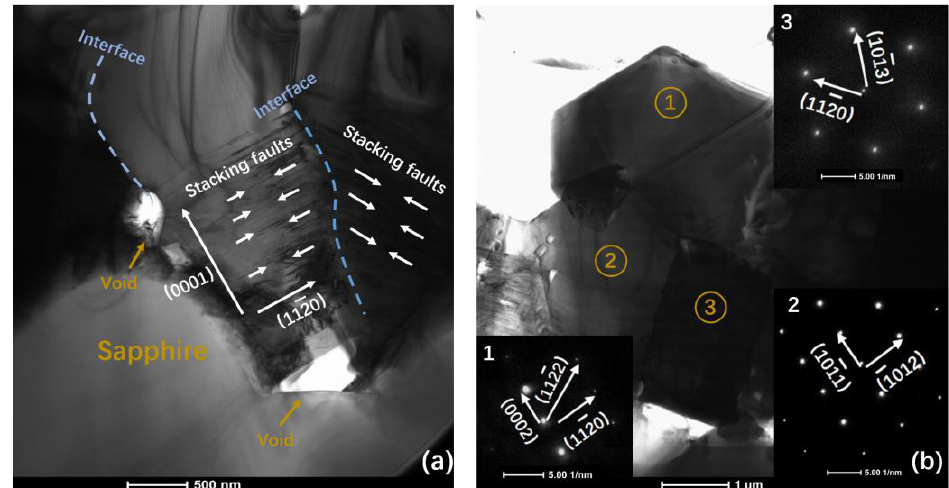
Figure 7. ( a ) The STEM image of the GaN film on the 10 nm sputtered AlON/PSS. ( b ) SAED patterns of the GaN film on the 10 nm sputtered AlON/PSS template.